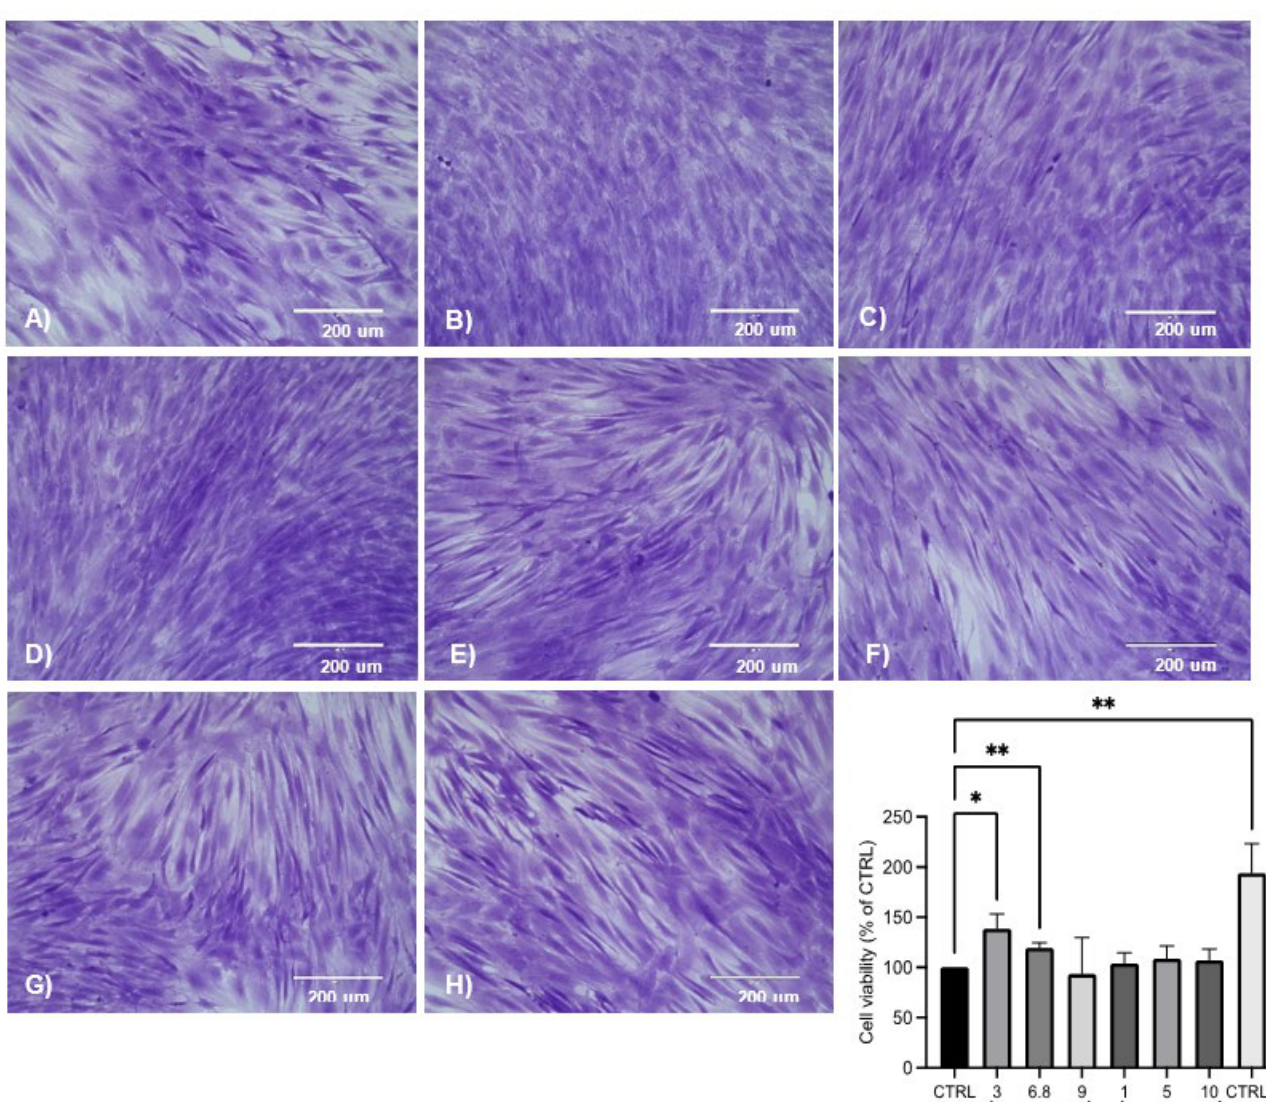
Figure 2. Morphology of SM-MSCs at different concentrations of UA and MSU crystals. Bright- field microscopy of SM-MSCs cultured with UA and MSU crystals. ( A ) Control, ( B ) 3 mg/dL UA, ( C ) 6.8 mg/dL UA, ( D ) 9 mg/dL UA, ( E ) 1 μg/mL MSU crystals, ( F ) 5 μg/mL MSU, ( G ) 10 μg/mL MSU, and ( H ) osteogenic medium (20×). Representative images of independent experiments ( n = 6). ( I ) Cell viability increased in cultures treated with 3 and 6.8 mg/dL UA and in cells cultured in osteogenic medium. The data represent the mean ± SD of independent experiments (* p < 0.05 vs. control; ** p < 0.001 vs. control).